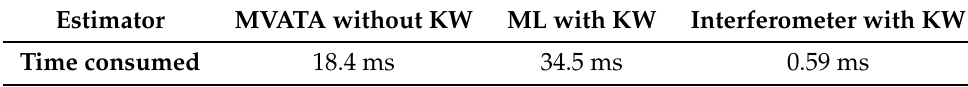
Table 1. Average time consumed per run of the three estimators.